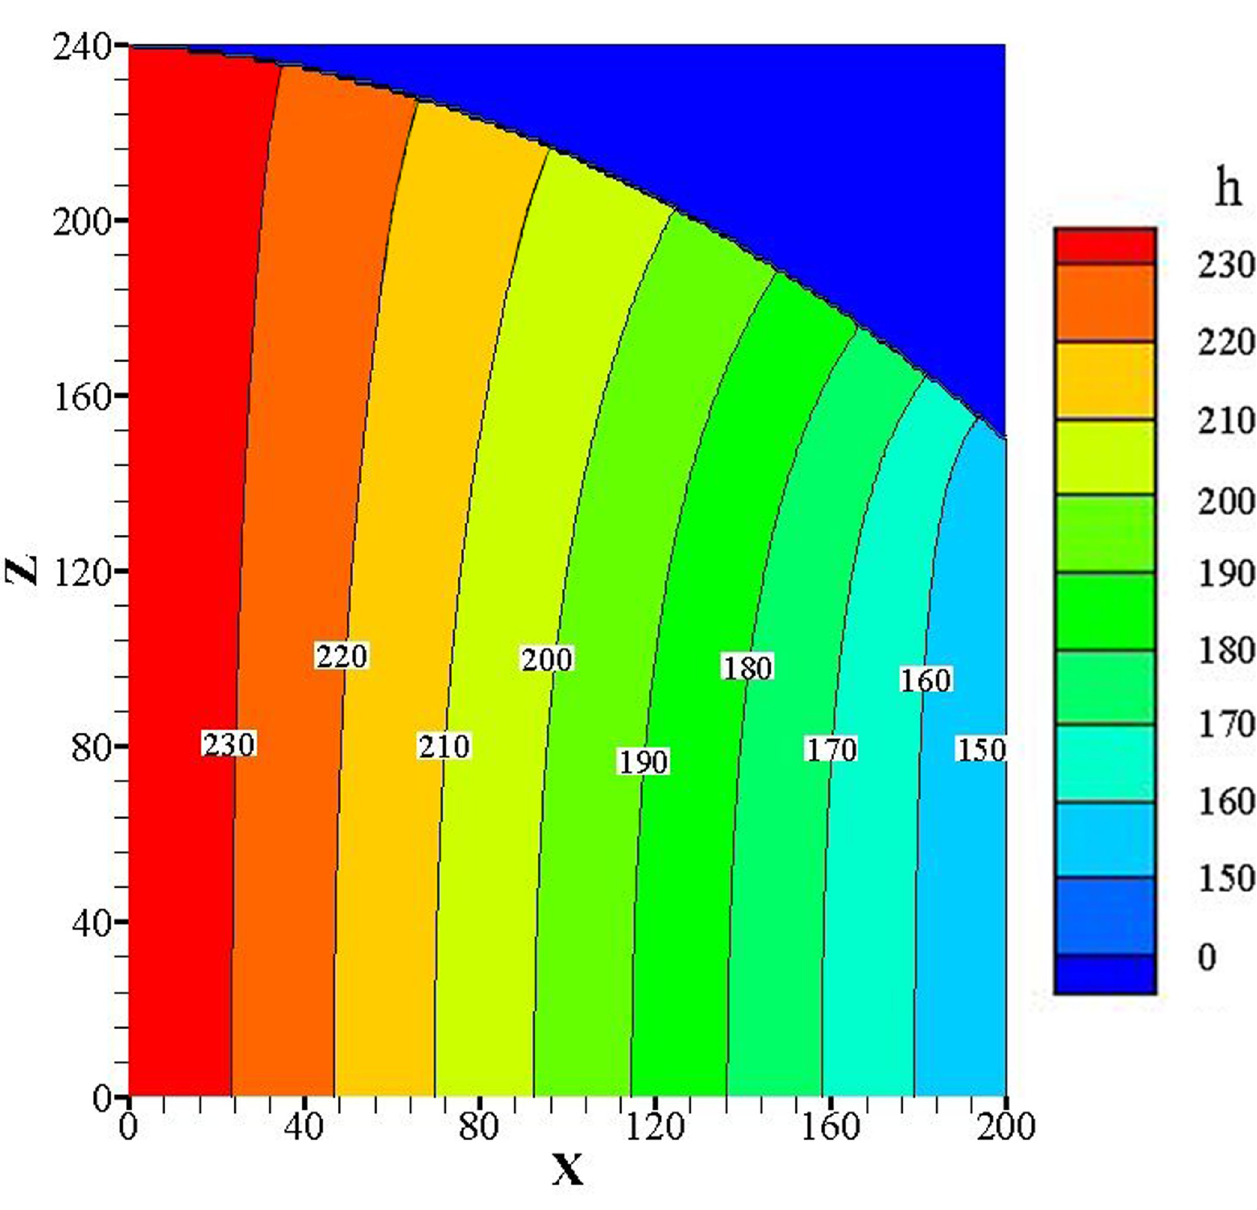
Fig 9. Schematic of equipotential lines in steady